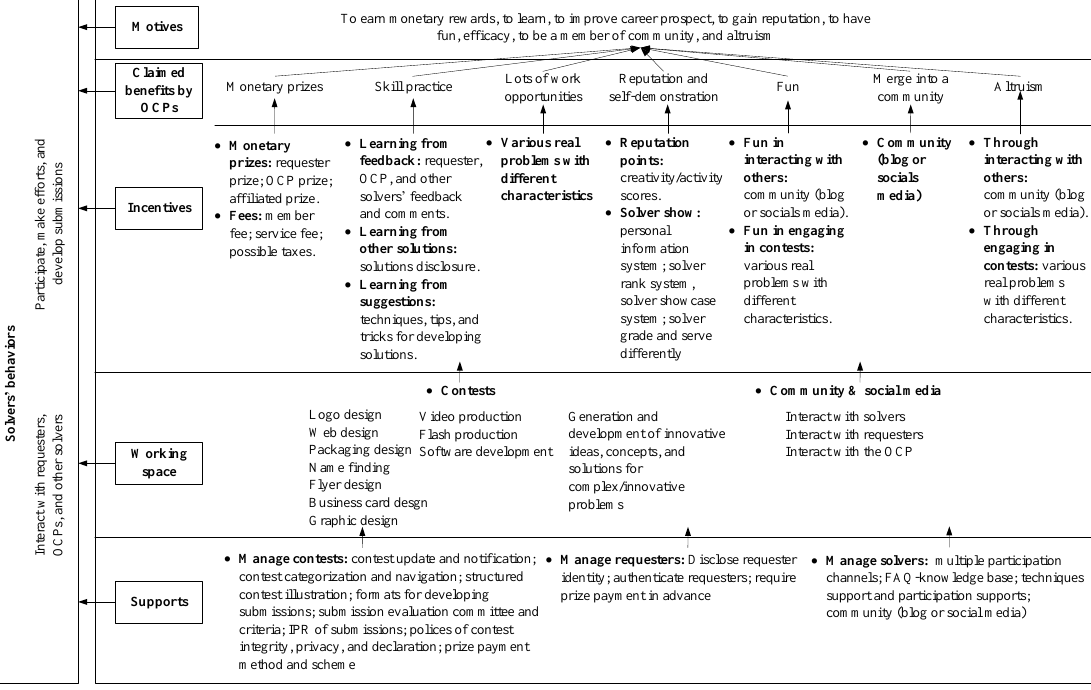
Figure 2. The identified service attributes and their relations.